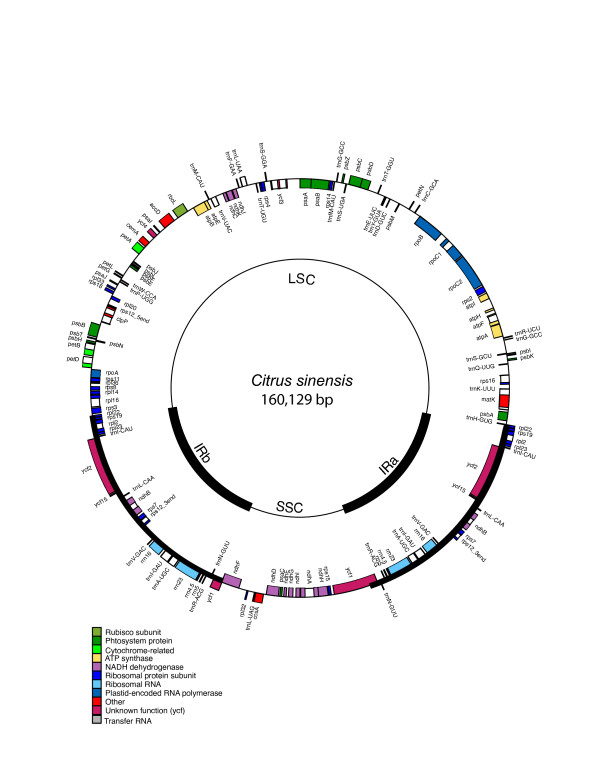
Circular gene map of Citrus sinensis chloroplast genome. The thick lines indicate the extent of the inverted repeats (IRa and IRb, 26,996 bp), which separate the genome into small (SSC, 18,393 bp) and large (LSC, 87,744) single copy regions. Genes on the outside of the map are transcribed in the clockwise direction and genes on the inside of the map are transcribed in the counterclockwise direction.